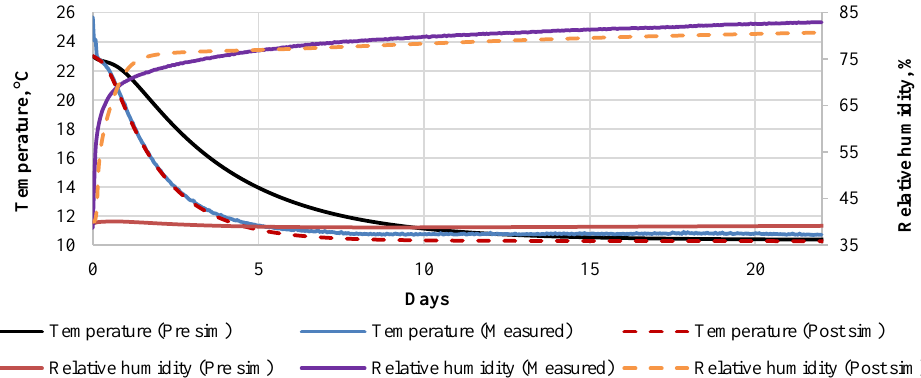
Fig. 11. Behaviour of temperature and relative humidity between masonry and mineral wool with vapour barrier ( s d = 12 m) insulation layer: simulation before and after experiment, and measured